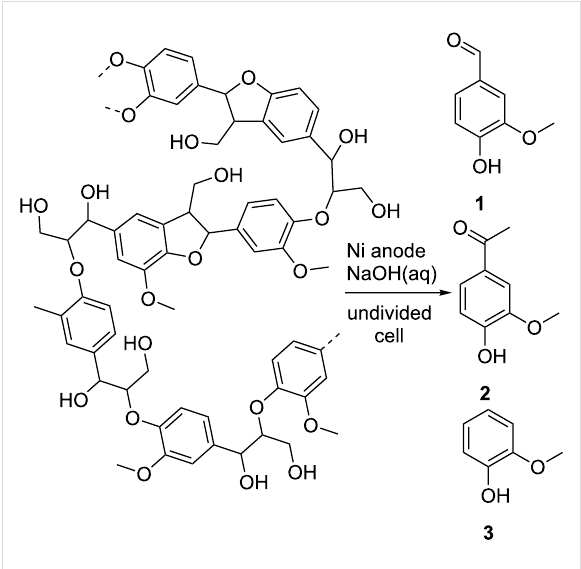
Table 1: Influence of the anode material on the electrochemical degradation of lignin. a